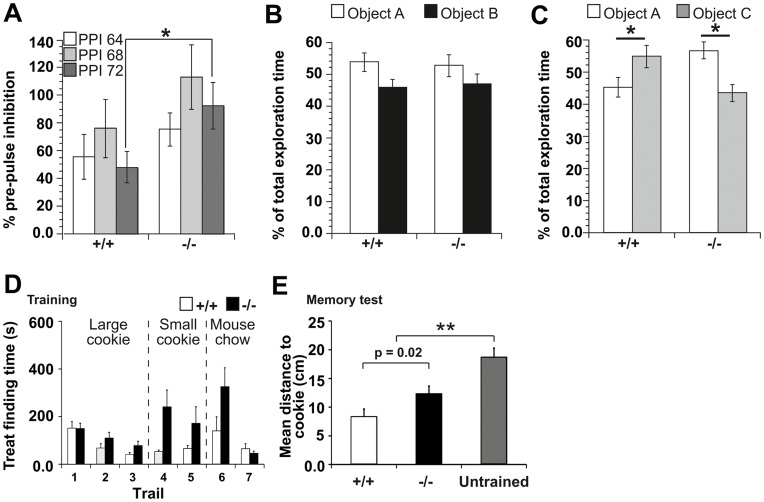
Behavioral dysfunctions of Panx1−/− mice.a, Pre-pulse inhibition of the acoustic startle response (PPI) showing a tendency towards lower levels in Panx1−/− (n = 8) compared to Panx1+/+ (n = 6) mice at the intensities of 62 and 64 dB. At the intensity of 72 dB, a statistically significant reduction of the PPI is detected. b, Object recognition was equivalent in both Panx1+/+ and Panx1−/− mice when the animals were allowed to explored two novel objects (A and B) for 5 minutes. c, One hour later control Panx1+/+ mice explored the now familiar object A significantly less than the novel object C. By contrast, Panx1−/− animals explored object C with significantly less intensity than object A. d, Cookie finding test: Training trials were performed on seven subsequent days, where in trial 1 and 2 a large cookie was used (500 mg), in trial 4 and 5 a smaller cookie (50 mg), and in trial 6 and 7 replaced by a very weak-odorous mouse chow. The time till the mice held the treat in their front paws is depicted in the bar diagram. Panx1−/− performed equal to Panx1+/+ mice in this experiment (P>0.05, Student’s t-test) e, A further trial was performed after training trails where no treat was hidden (Movie S1). Bar graphs depict the mean distance of the mice to the location where the cookie was hidden during training trials for the first 60 s. Error bars represent SEM. n = 9 for each mouse group. Panx1 knock out mice have an impaired memory, as they spent less time searching at the correct position (P = 0.02). However, they still remembered the former location to some extent, as they spent significantly more time searching at the correct position as untrained animals (P<0.001, Student’s t-test).